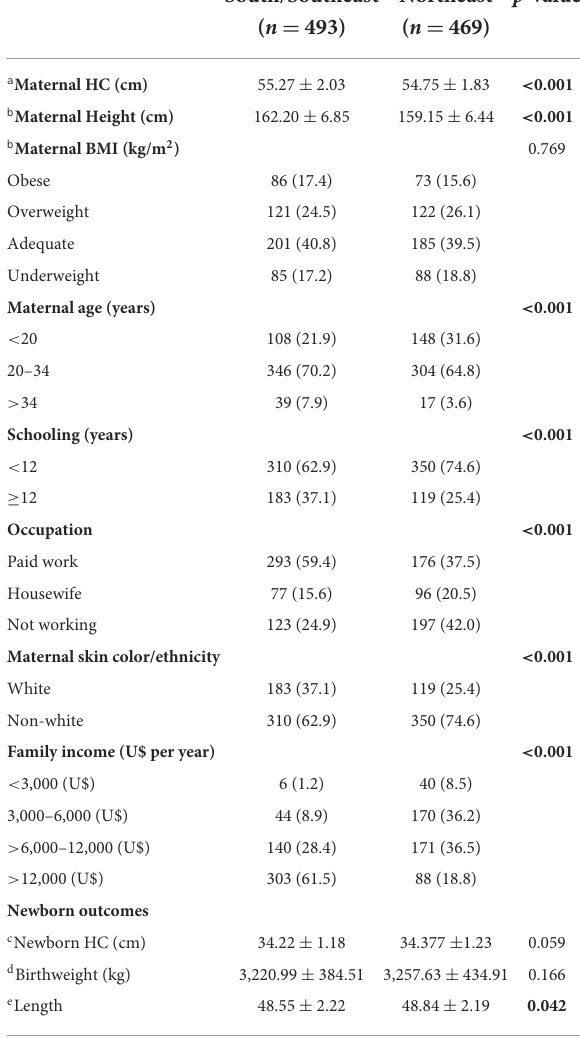
TABLE 1 Distribution of anthropometric and sociodemographic characteristics according to the regions of Brazil (n = 962). South/Southeast Northeast p